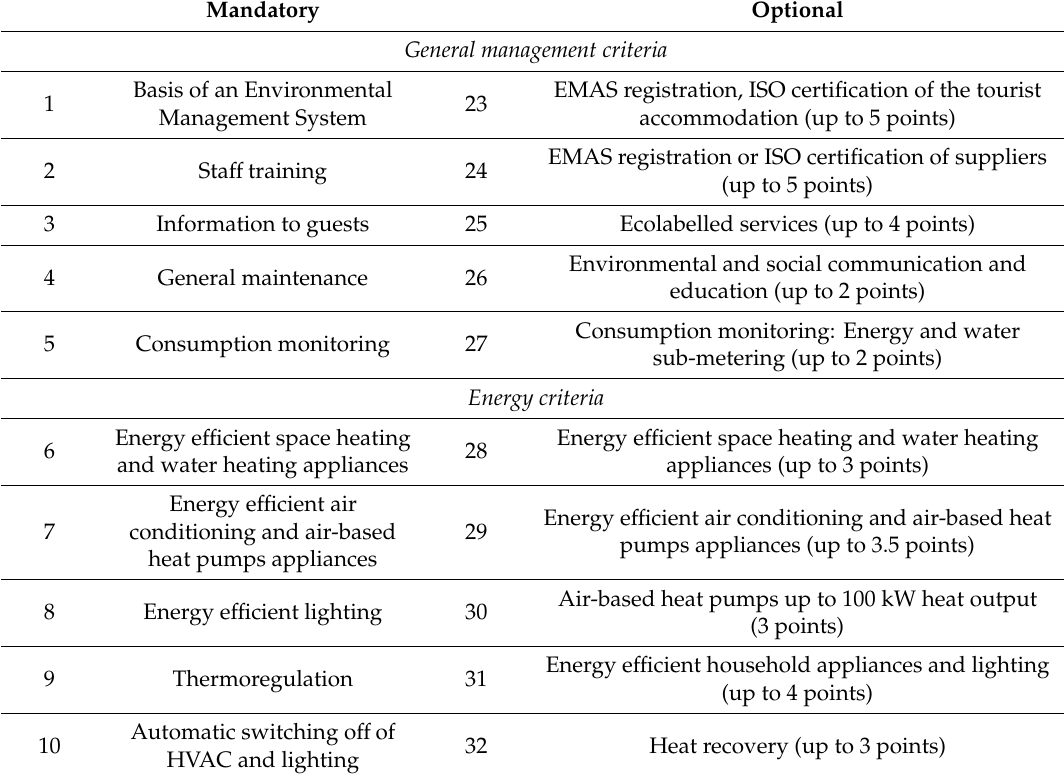
Table A2. EU Ecolabel for Tourist Accommodation Services